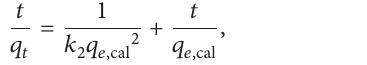
where the value of ℎ 𝑖 is the initial metal adsorption rate (mg/g from the intercept and slope of the line obtained by plotting 𝑡/𝑞 The kinetic data obtained from Pb (II) adsorption exper- iments were analyzed using the pseudo-first-order kinetic model according to (2) and the results are given in Table 5.